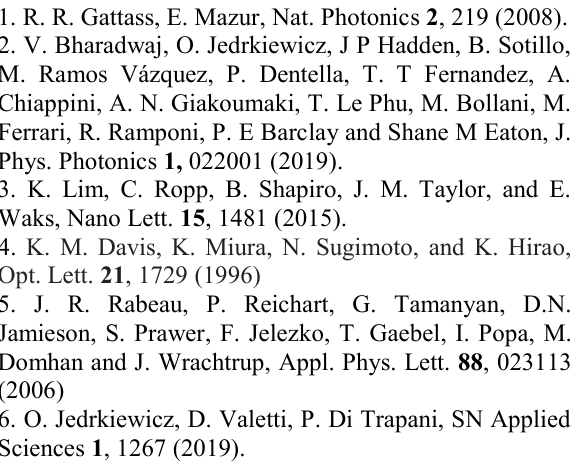
pulse parameters, without any sample translation (Fig.2).